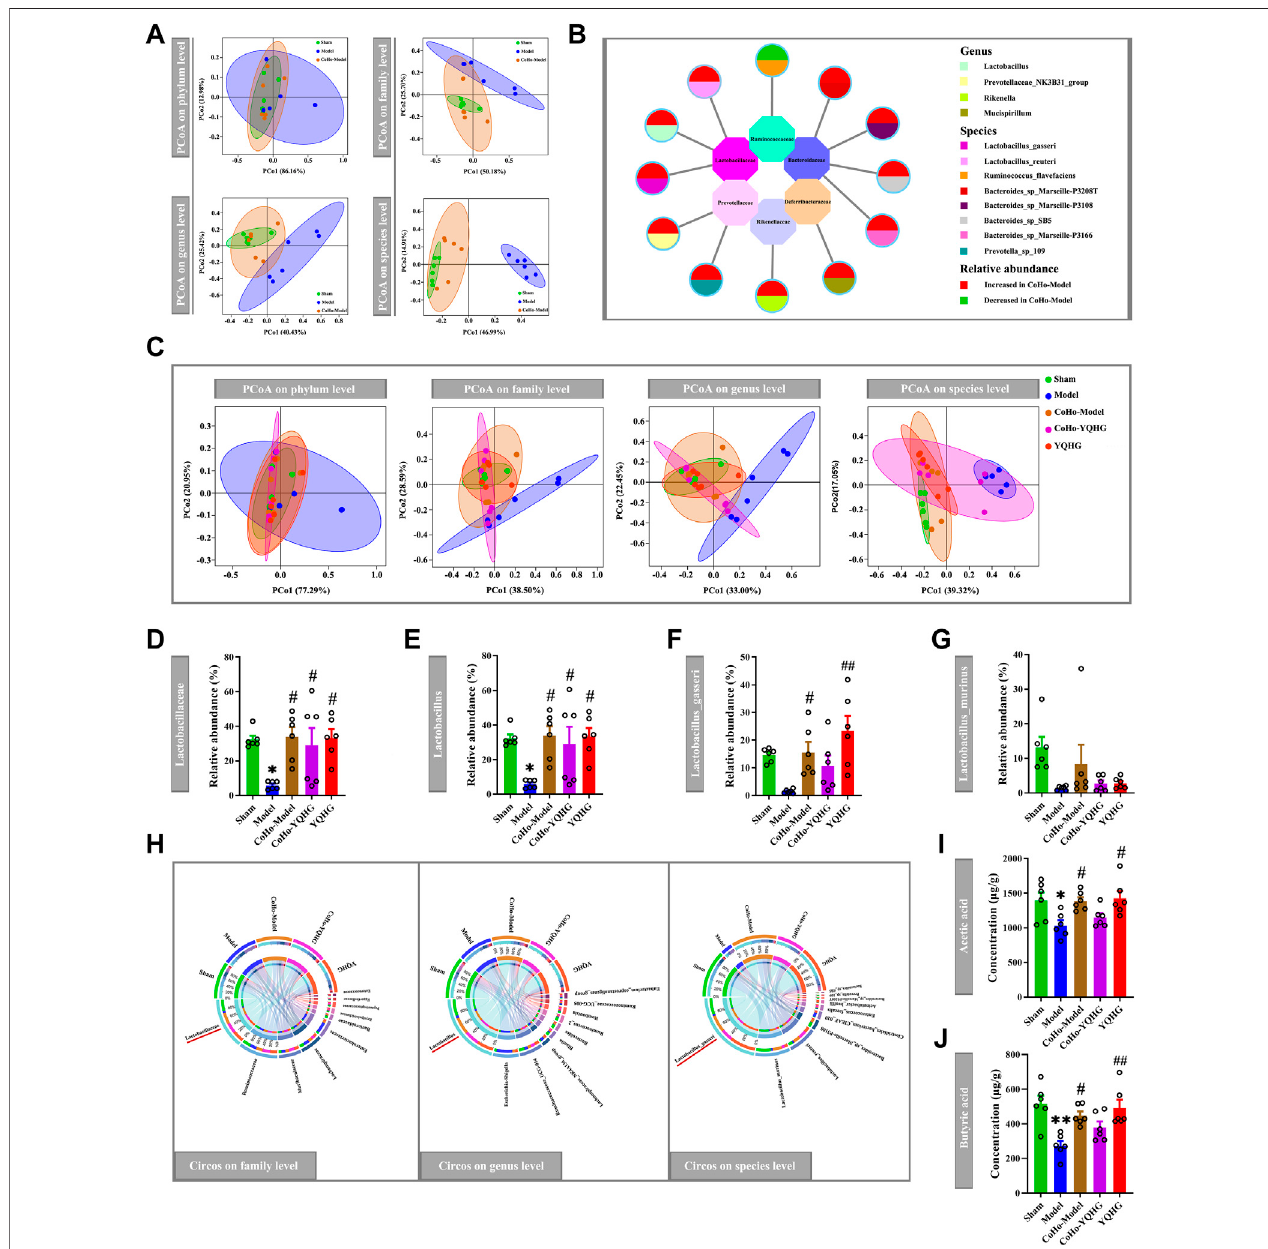
FIGURE 8 | The alteration of gut microbiota and SCFA concentrations in co-housed rats. (A,B) Fecal transfer (transplant) from YQHG-treated rats modulates gut microbiota composition. PCoA based on Bray-Curtis distance in bacterial communities on four levels (phylum, family, genus, species) (A) . Differences in bacterial taxa between the model group and the CoHo-model group (B) . (C – J) The alteration of gut microbiota and SCFA concentrations in fi ve groups. PCoA based on Bray-Curtis distance in bacterial communities on four levels (phylum, family, genus, species) (C) . Relative abundances of fecal Lactobacillaceae (D) , Lactobacillus (E) , Lactobacillus_gasseri (F) ,and Lactobacillus_murinus (G) .Circosdiagramofspecies-samplerelationshiponthree levels (family,genus, species) (H) .Theconcentrations of fecal acetic acid (I) and butyric acid (J) . All data are expressed as means ± SEM. For normally distributed data (Lactobacillus_gasseri, Acetic acid), one-way ANOVA followedbyTukey ’ stestwasused.Fornon-normallydistributeddata(Lactobacillaceae,Lactobacillus,Lactobacillus_murinus,Butyric acid),Kruskal-Wallistestfollowed by non-parametric Wilcoxon rank-sum test was used. * p < 0.05, ** p < 0.001 vs. the sham group; # p < 0.05, ## p < 0.01 vs. the model group.